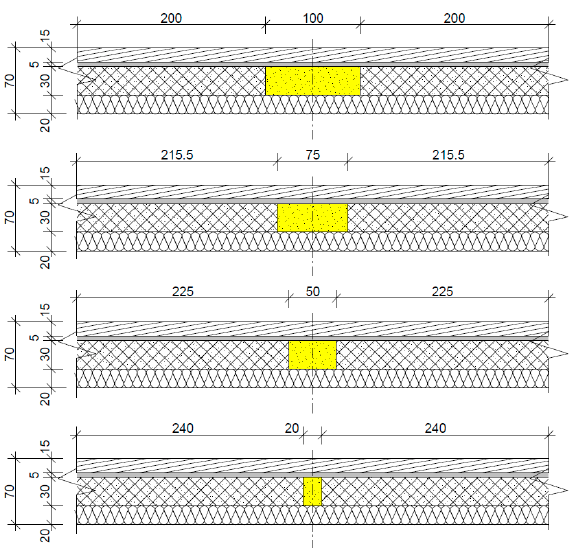
Figure 6. Diagram of a 70 mm thick panel with a PUR joint of 20–100 mm (yellow). Table 1. Material parameters considered for the calculation (typical values given by the manufac- turers of the given materials).